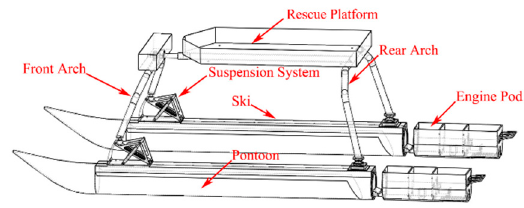
Figure 1. Structure of the rescue vessel.